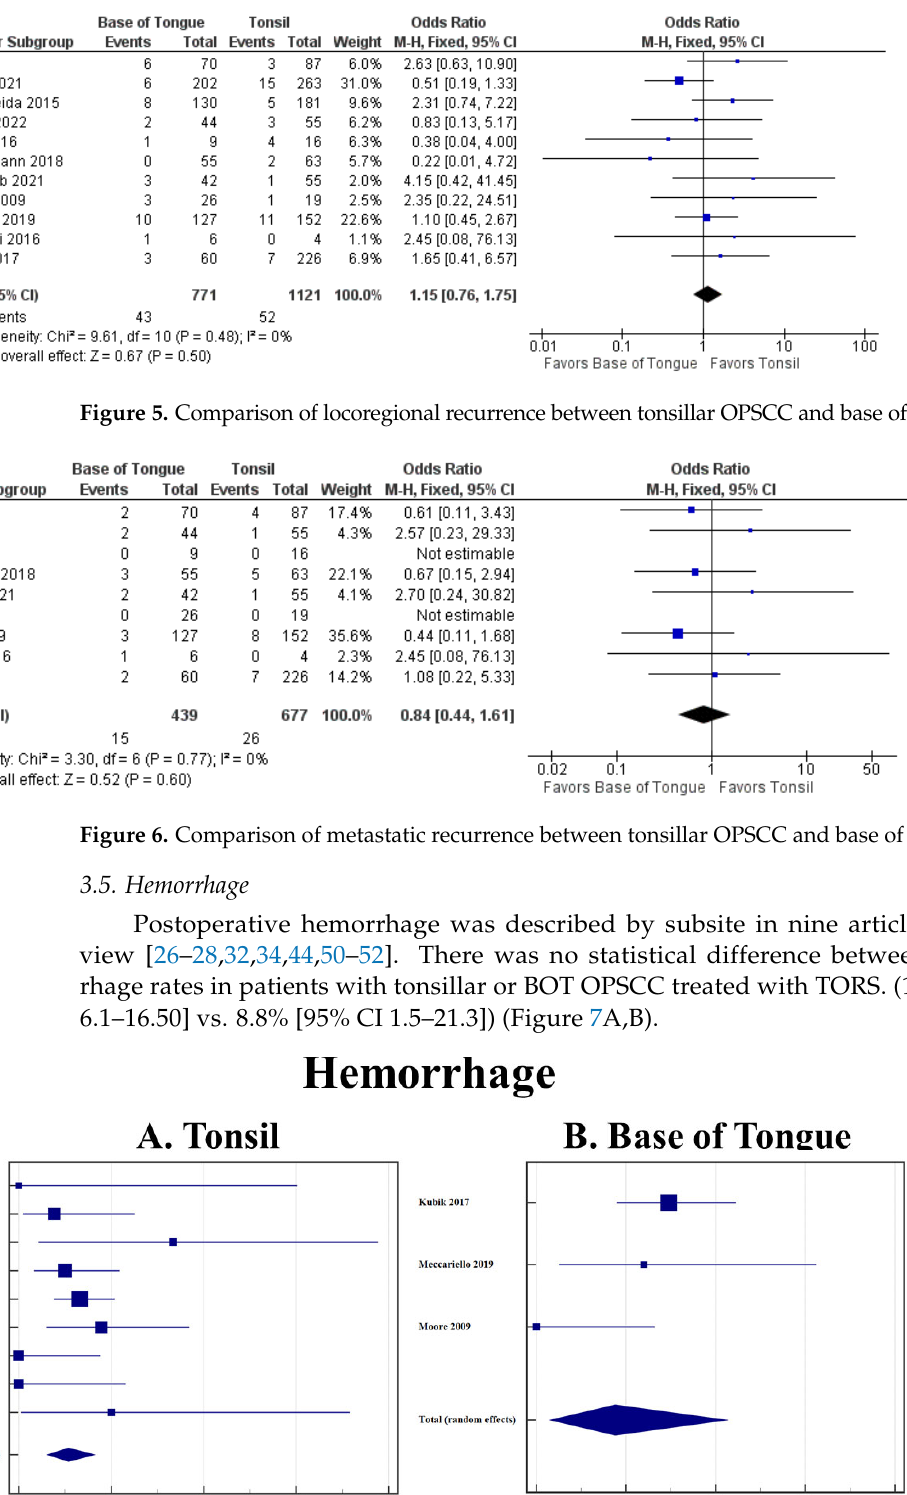
Figure 4. Comparison of total recurrence between tonsillar OPSCC and base of tongue OPSCC.